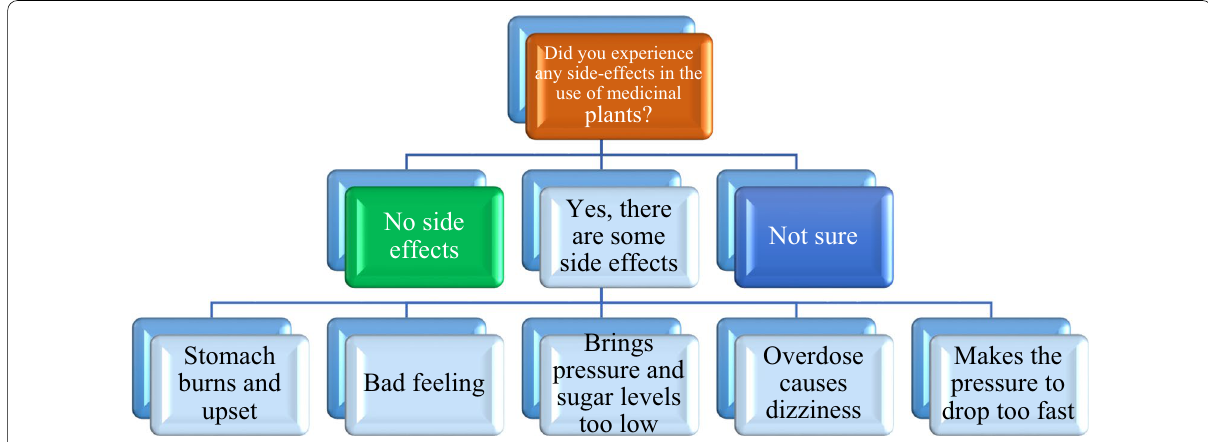
Fig. 1 Reported side effects in the use of medicinal plants for